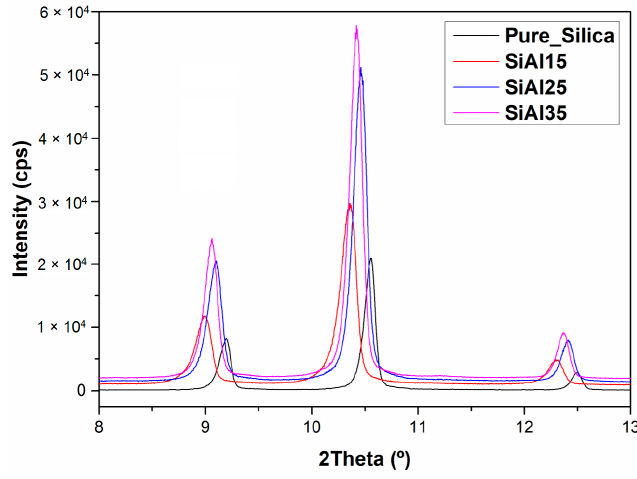
Figure 3. Magnified view of the X-ray diffractograms of the calcined samples.